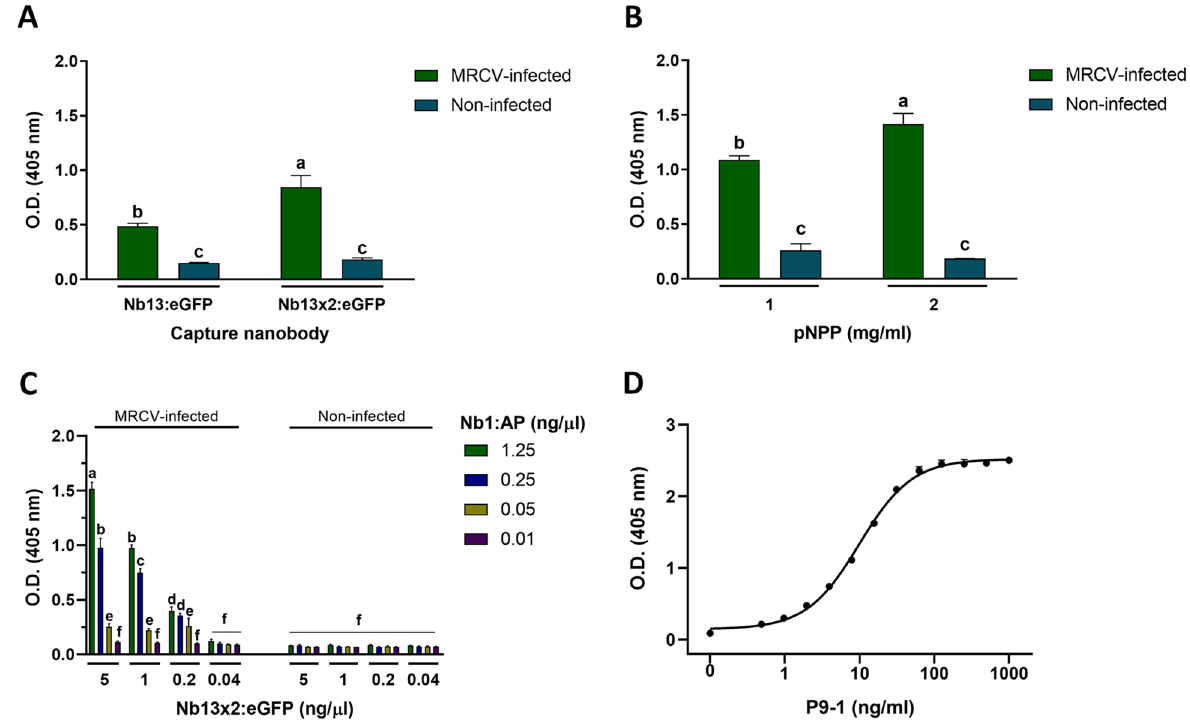
Figure 2. Sandwich ELISA optimization. ( A ) Assessment of bivalent Nb13 (Nb13 × 2:eGFP) as capturing antibody. Coating was performed with 100 µl of 6.83 ng/µl to achieve an equimolar amount of monovalent and bivalent Nb. ( B ) Assessment of different pNPP concentrations. ( C ) Checkerboard titration of Nb13 × 2:eGFP and Nb1:AP. ( D ) Four-parameter logistic model fit for the determination of the limit of detection (LOD). Values are means ± SD (n = 3). ANOVA followed by Tukey’s multiple comparison test was performed. Bars denoted by the same letter are not statistically significant (p >